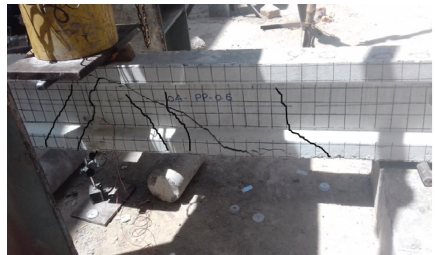
Figure 16: Crack patterns of B2-HyFRC.